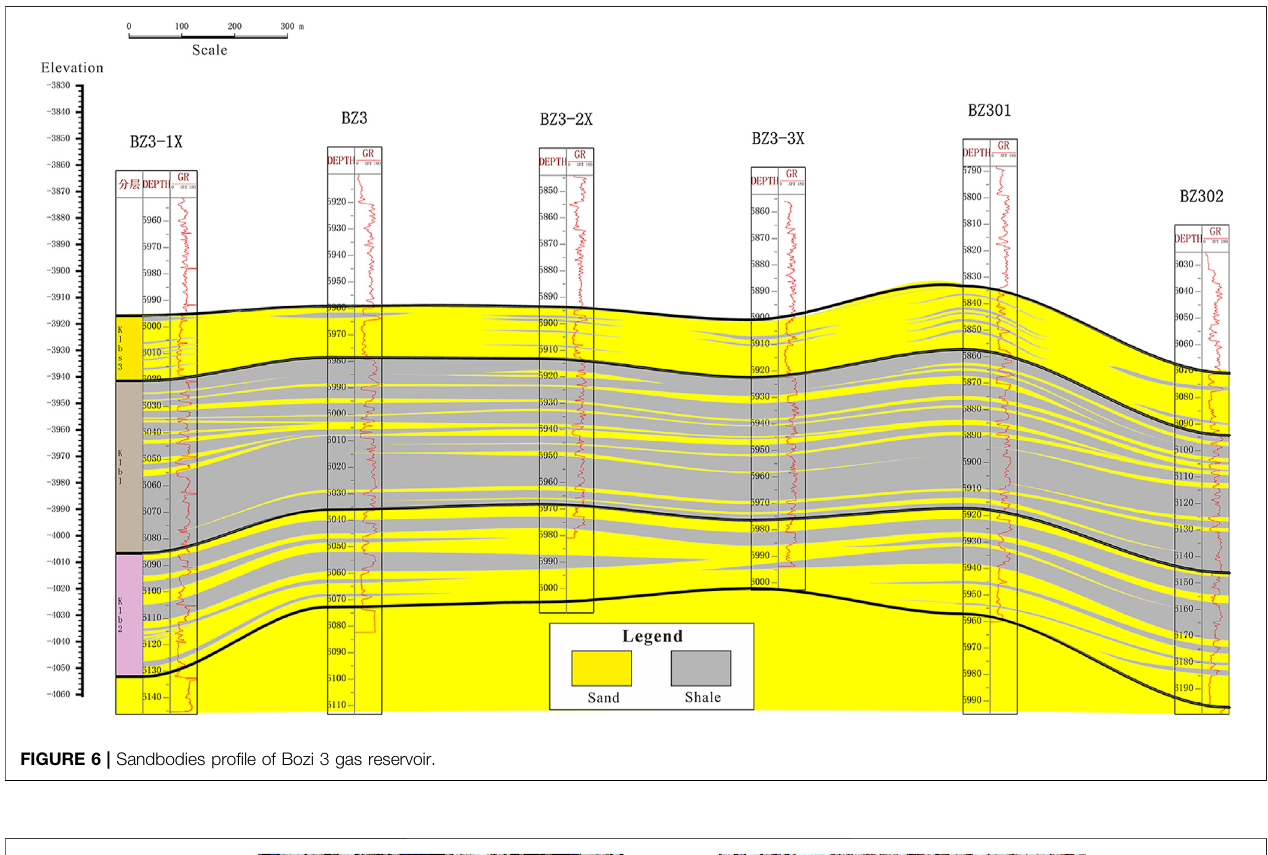
FIGURE 6 | Sandbodies pro fi le of Bozi 3 gas reservoir.